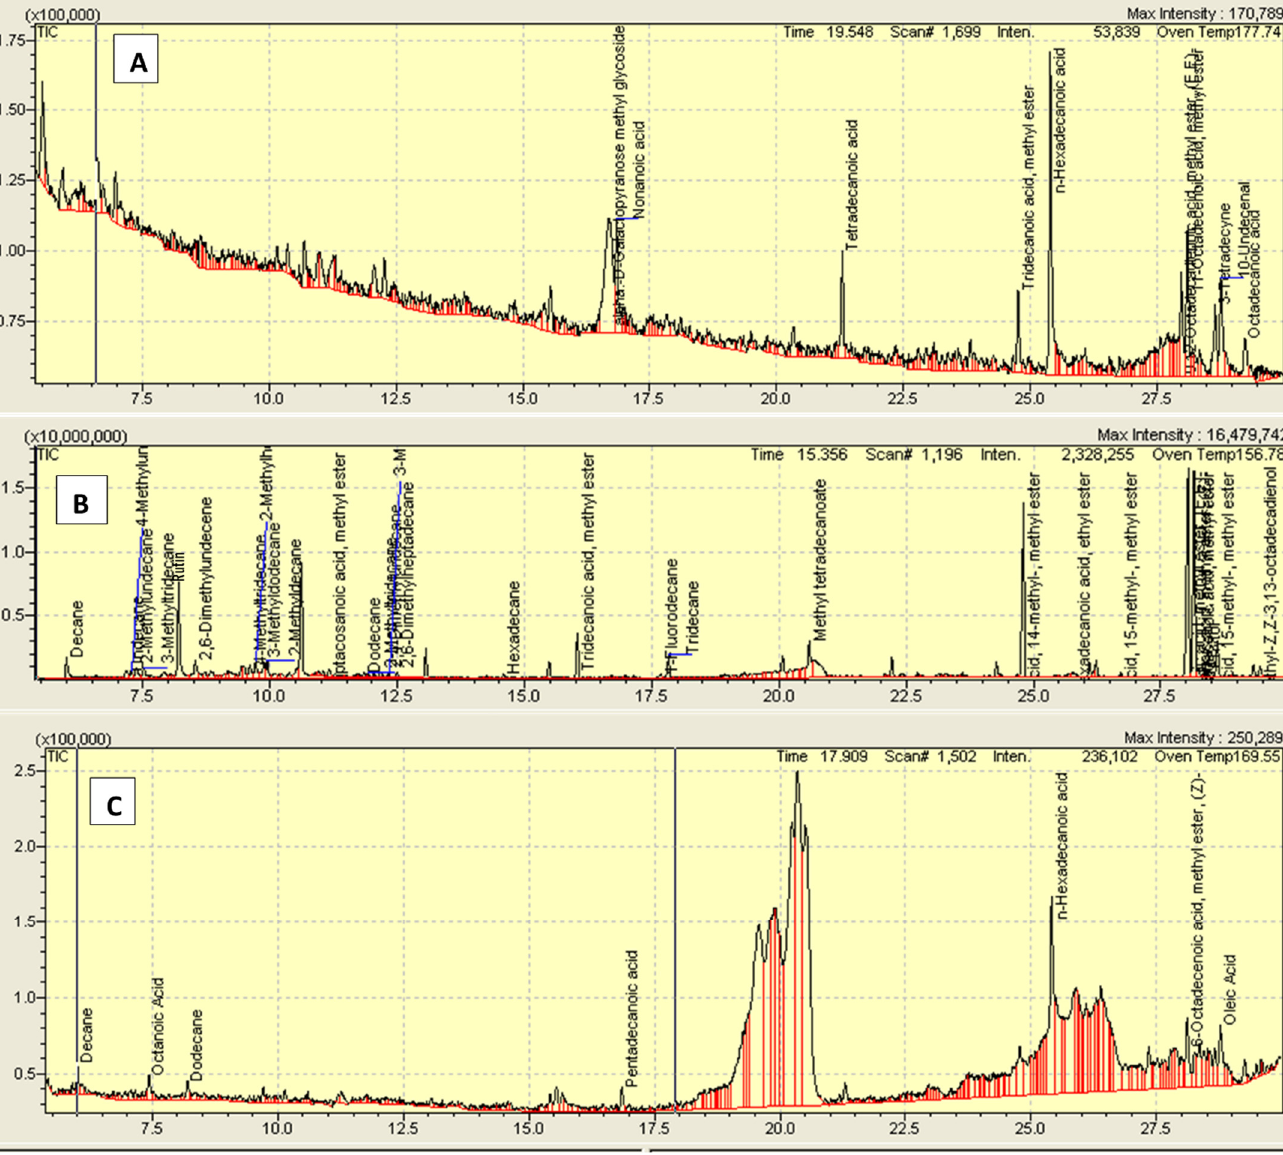
Figure 1. Chromatogram of ( A ) crude methanolic extract of Rumex hastatus (Rh.Cr), ( B ) n-hexane (Rh.n-Hex) and ( C ) ethyl acetate fraction (Rh.ETAC). Table 2. Gas chromatography-mass spectrometry (GC-MS) analysis of Rumex hastatus crude extract (Rh.Cr) and fractions: n-hexane (Rh.n-Hex) and ethyl acetate (Rh.ETAC). Samples R.Time